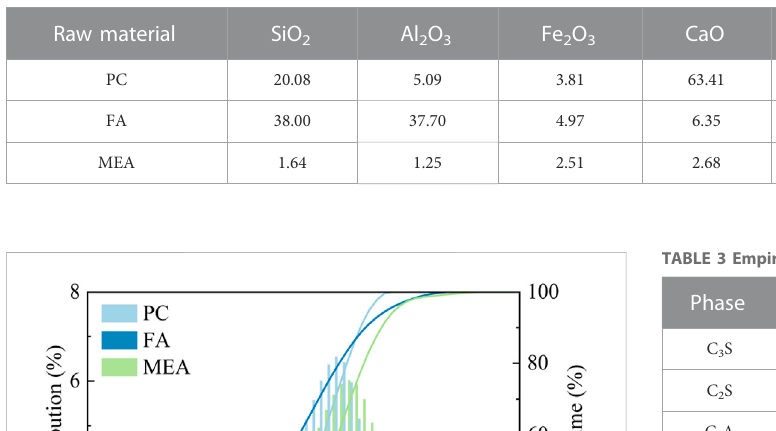
TABLE 1 Chemical compositions of the raw materials (%).